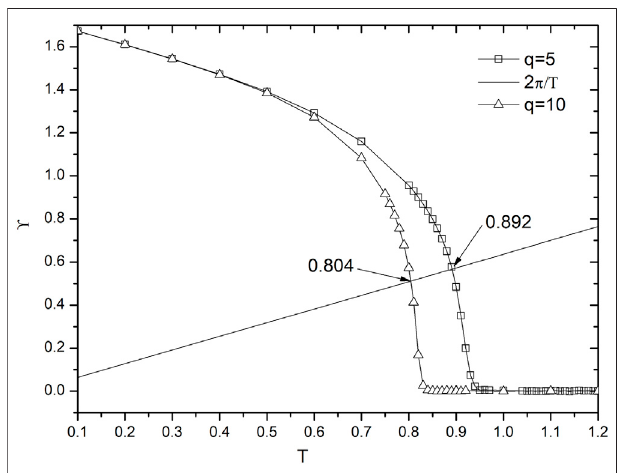
FIGURE 1 | Helicity modulus as a function of temperature for different q . The lattice size is L (cid:1)